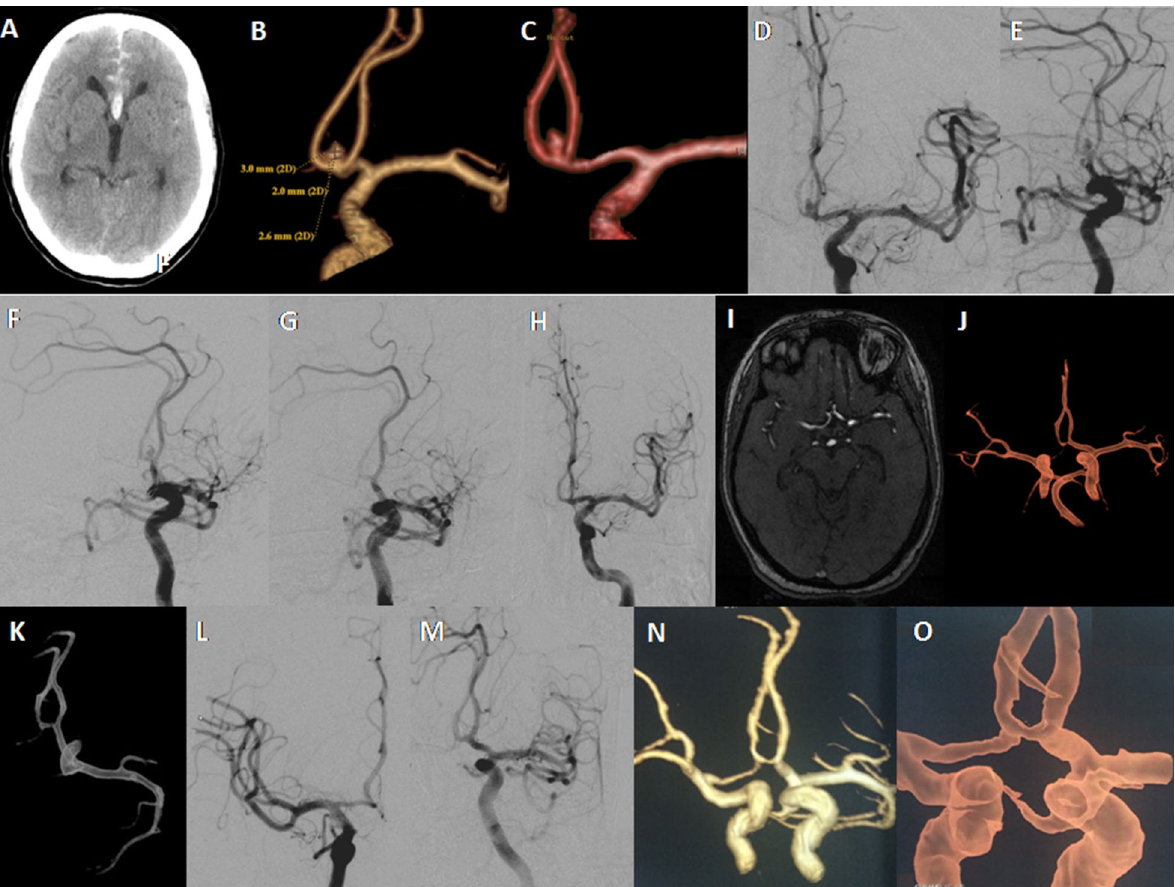
Fig. 2 GA case 52-year-old lady presented to our hospital by SAH from ruptured AcomA aneurysm H&H showed diffuse SAH with main cast at the anterior interhemispheric fissure, B , C preoperative CT angiogram volume rendering 3D reformate showed a small narrow neck AcomA aneurysm directed anterosuperiorly with the following dimensions (3.0 A–P view and working view angle DSA showing the AcomA aneurysm before coiling, F preoperative DSA working angle view showing the microcatheter inside AcomA aneurysm before coiling, G , H post-coiling (under GA) working angle view and A-P view DSA showing complete aneurysm obliteration (CO), I axial source image MRA 6-month FU showing stable aneurysm obliteration, J , K postprocedural 6-month FU MRA 3D volume rendering transparent formate that showed stable complete aneurysm obliteration (CO), L , M 1-year FU DSA Rt. ICA A–p view and left ICA working angle view that showed stable complete obliteration (CO), N , O 3-year postprocedural FU MRA 3D volume rendering transparent formate that showed stable complete aneurysm obliteration